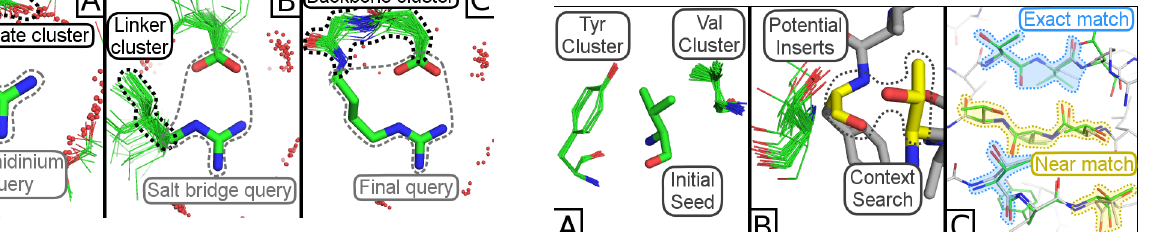
Figure 4. Building a tertiary interaction. (A) Three strands are seeded by searching on a valine, which reveals two nearby clusters of valine and tyrosine. (B) Strands are extended one residue in each direction by searching for pairs of residues (colored yellow) in the context of an insertion site, yielding clusters of potential inserts (colored green). (C) The final backbone fragment (green) is fed to MadCaT, which identifies multiple compatible scaffolds. One such scaffold (PDB ID=1E54, colored light grey) possesses many exact residue/rotamer matches to the assembled fragment (blue highlights) and many close matches (yellow highlights) that differ by a related residue (threonine to serine or valine to isoleucine) or by varying the rotamer.